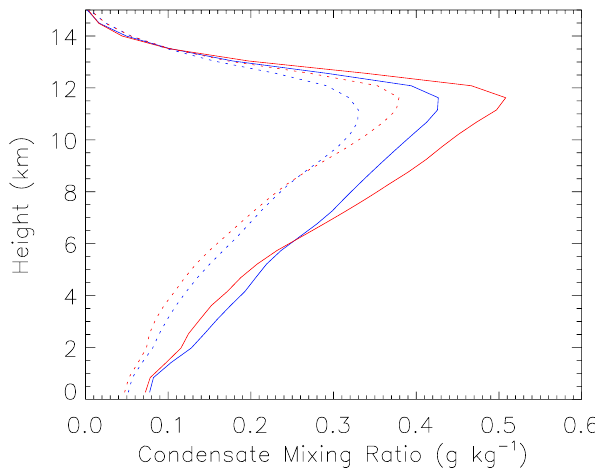
Fig. 14. (a) Vertical profiles of domain-mean total hydrometeor mixing ratios for the baseline configuration (BASE) at t = 90min (dotted) and t = 120min (solid). Pristine and polluted conditions are shown by blue and red lines,